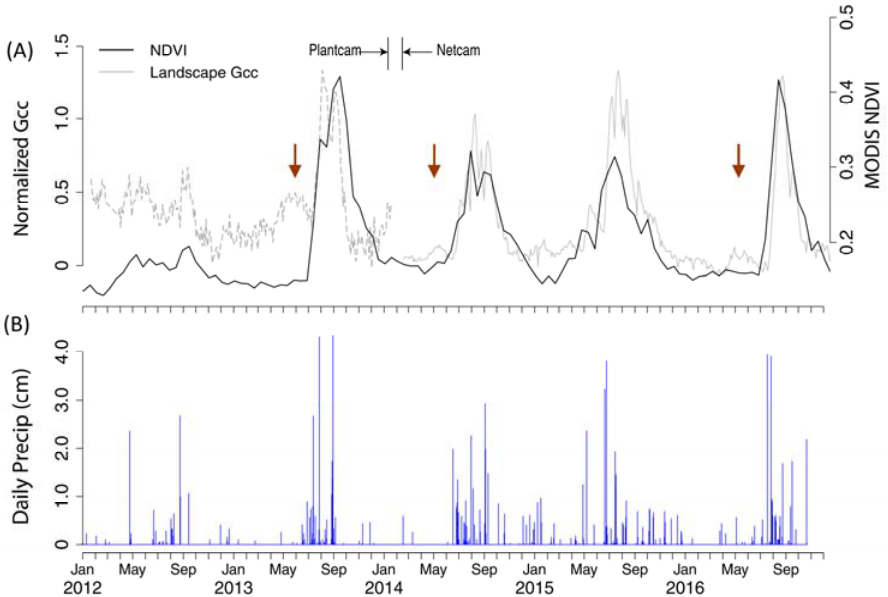
Figure 7. Landscape GCC from Plantcam (dotted gray) and Netcam (solid gray) digital cameras with MODIS NDVI (black line) ( A ). Brown arrows in ( A ) indicate increases in landscape GCC reflecting mesquite green-up as shown in Figure 4C. Daily precipitation (cm) is depicted ( B ).